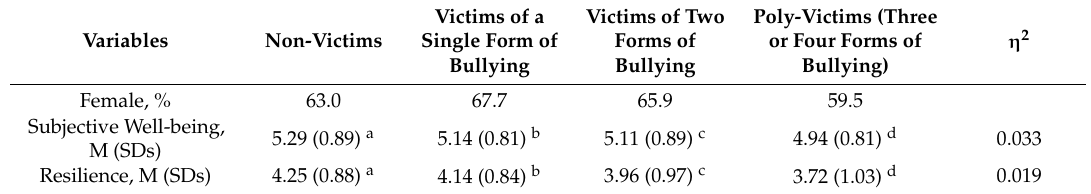
Table 2. Descriptive analyses of participants’ gender, well-being and resilience among the university students with or without di ff erent bullying victimization profiles.